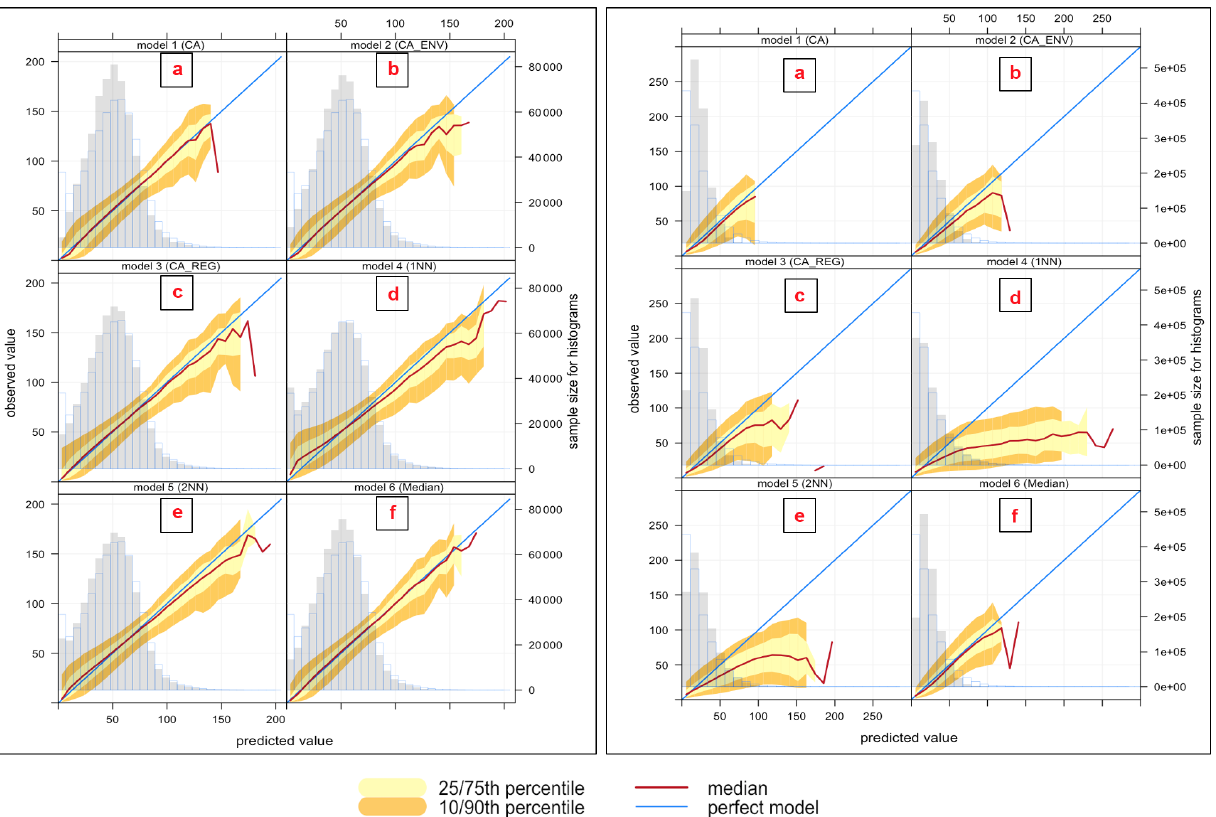
Figure 2. Conditional quantile plot of modelled and observed pollutant concentrations of O 3 (left plot) and NO 2 (right plot) for proposed imputation models: (a) model 1 (CA), (b) model 2 (CA + ENV), (c) model 3 (CA + REG), (d) model 4 (1NN), (e) model 5 (2NN), (f) model 6